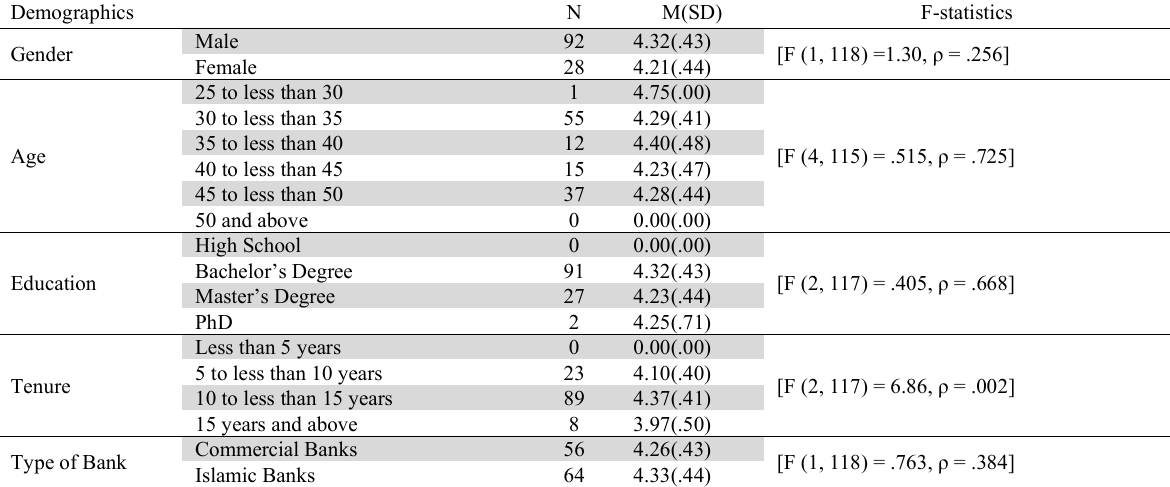
ANOVA for process innovation and demographics